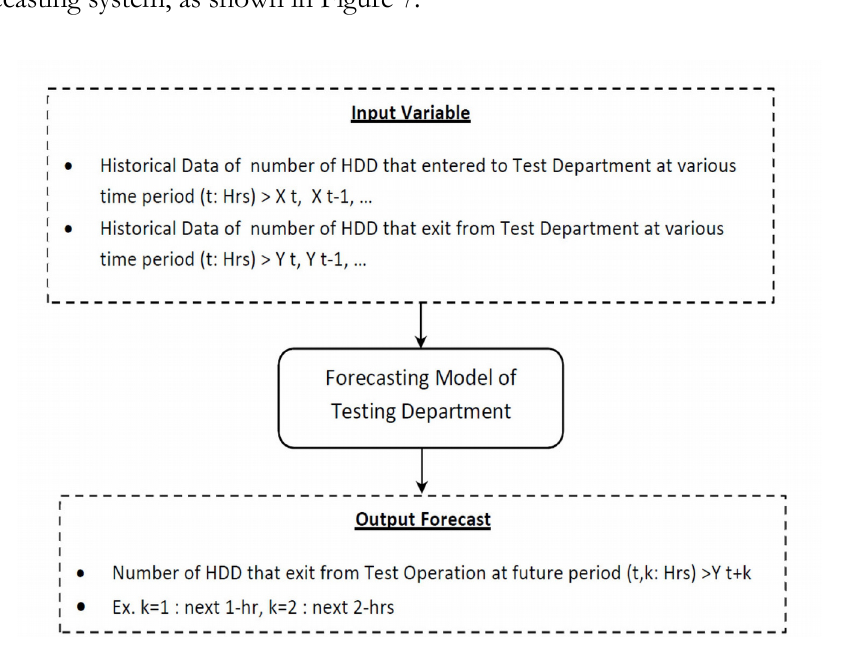
Figure 7. Input and output variables for the forecasting